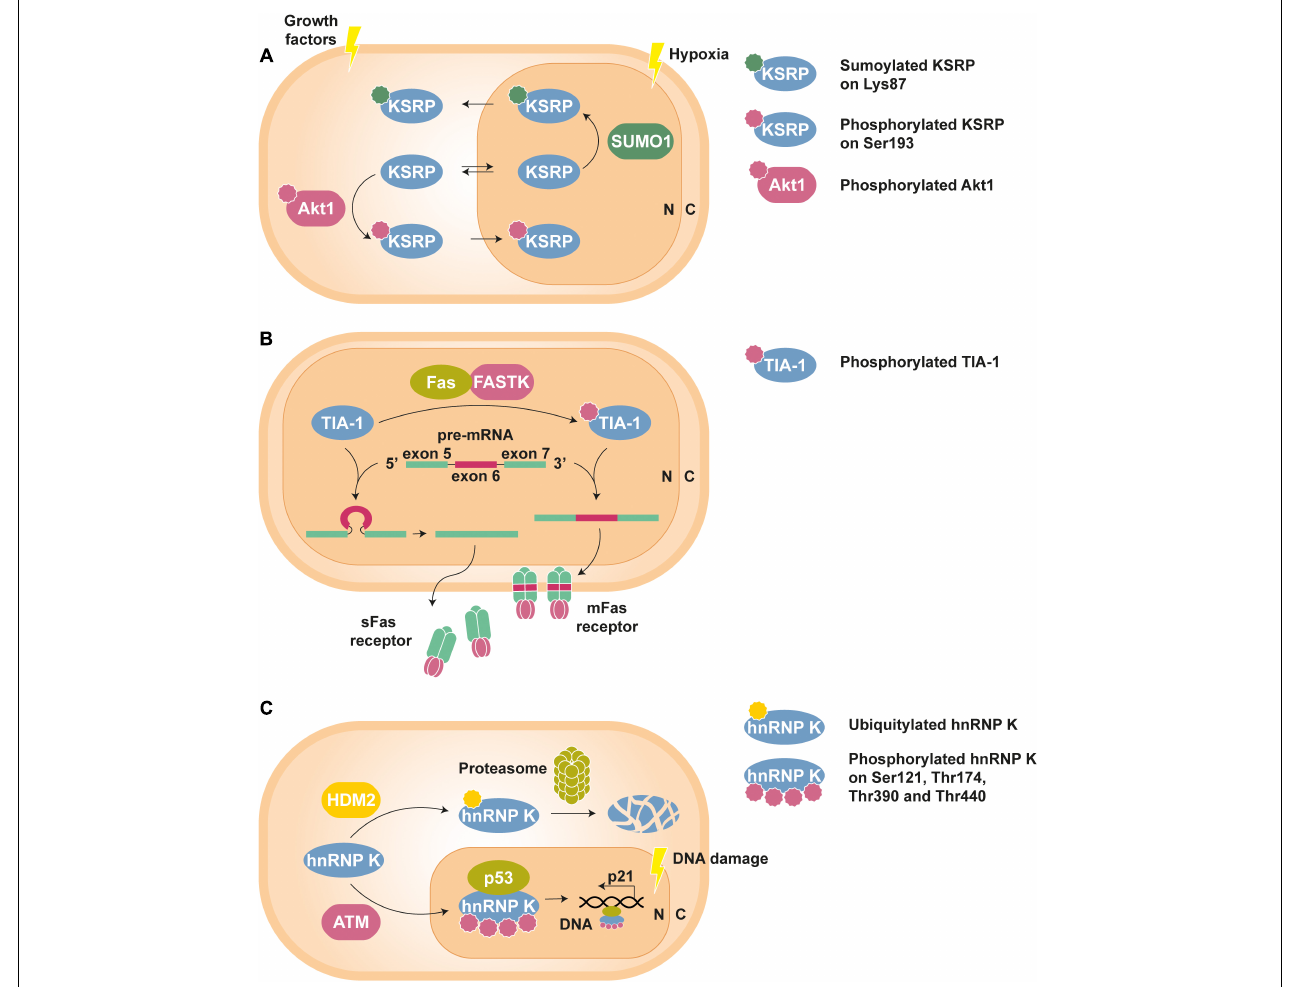
FIGURE 1 | Examples of PTM-mediated regulation of RBPs. (A) KSRP can shuttle between nucleus (N) and cytoplasm (C) to perform specific functions in each compartment. However, phosphorylation at Ser193 by Akt1, stimulated by growth factors, promotes the translocation of KSRP to the nucleus, whereas hypoxia-induced SUMOylation at Lys83 leads to its nuclear export (Díaz-Moreno et al., 2009; Yuan et al., 2017). (B) Phosphorylation of TIA-1 by FASTK improves its ability to recruit the U1 snRNP spliceosomal complex to the 5 (cid:48) splice site region of the Fas receptor pre-mRNA exon 6. The resulting mature mRNA will express mFas, which plays an important role in the extrinsic apoptosis signaling pathways. In contrast, splicing of Fas receptor in the presence of unphosphorylated TIA-1 results in exon 6 skipping and the synthesis of sFas, that blocks apoptosis (Förch et al., 2002; Izquierdo and Valcárcel, 2007). (C) Under standard conditions, hnRNP K is targeted by the E3 Ub-ligase HDM2 for proteasomal degradation. Nonetheless, DNA damage triggers ATM-dependent phosphorylation of hnRNP K at Ser121, Thr174, Thr390, and Thr440, thus lowering its turnover rate. In addition, phosphorylated hnRNP K stimulates p53-mediated p21 gene expression, which causes cell cycle arrest (Moumen et al., 2005,